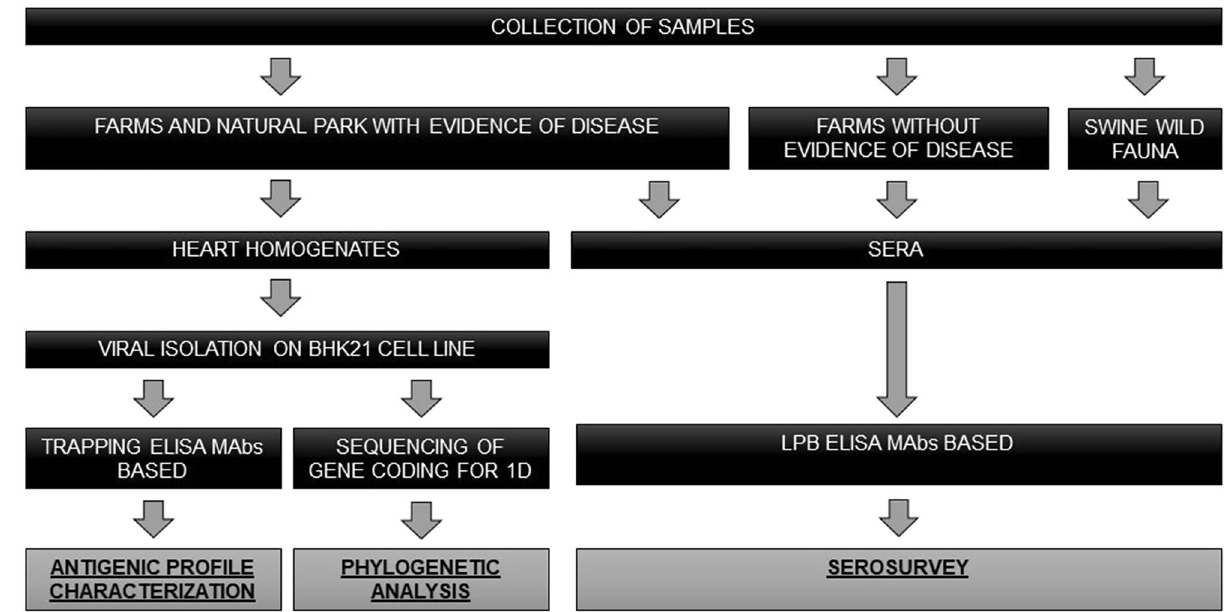
Figure 2. Workflow. The diagram shows the pattern of activities and experiments carried out, from sampling to obtainment of data. In dark cells, all the operations performed to get the results, presented in lighter cells.